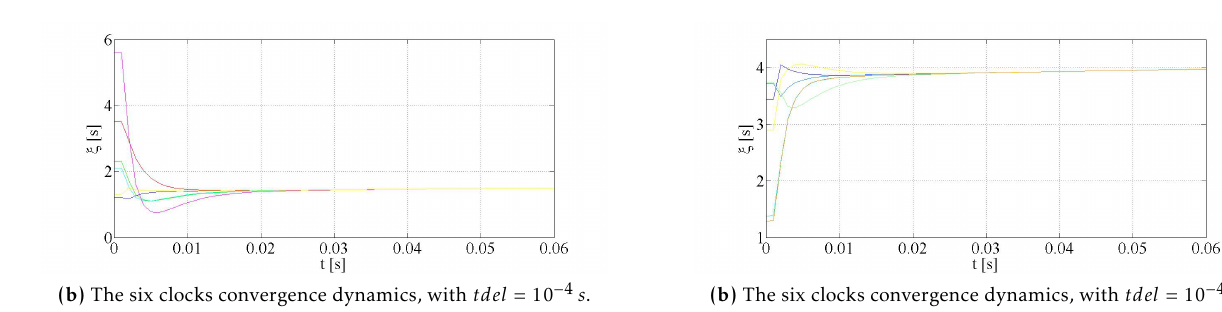
Figure 16. The clocks behavior of the six nodes with centralized topology.